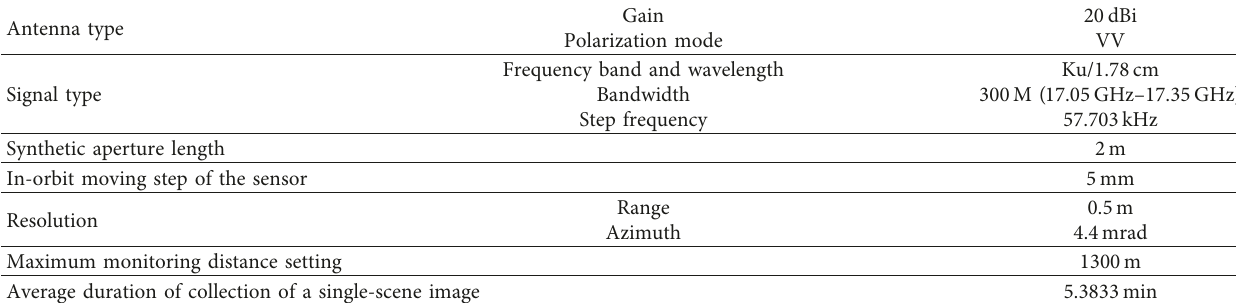
Figure 1: GB-SAR monitoring equipment layout diagram. The lower left corner shows the corresponding locations of the buildings and structures in a GB-SAR Table 1: Basic information of dam deformation monitoring data collection.